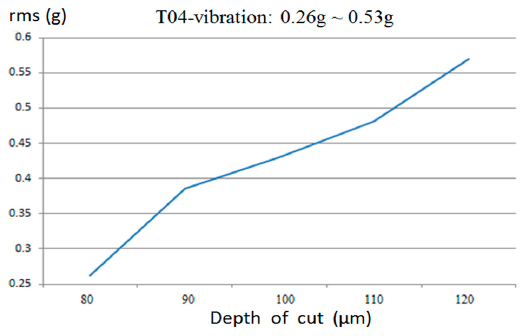
Figure 10. Cutting vibration vs. depth of cut for T04.